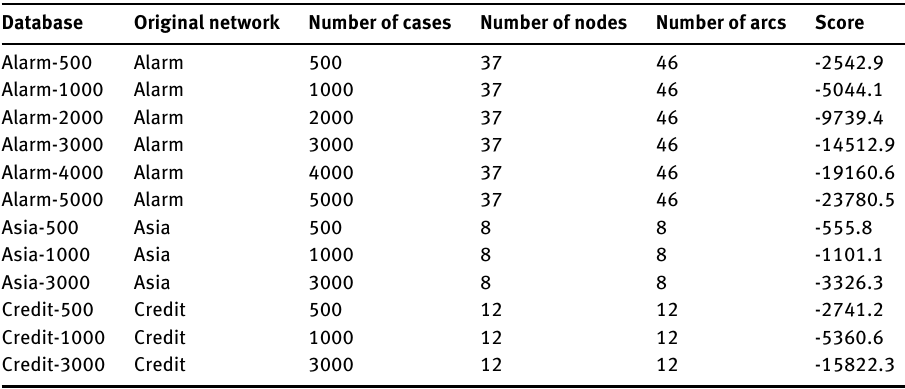
Table 1. Databases used in